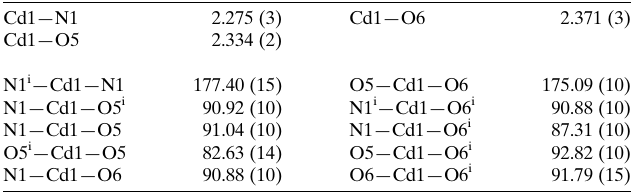
Table 2 Selected geometric parameters (A˚ , (cid:3) ) for (II).